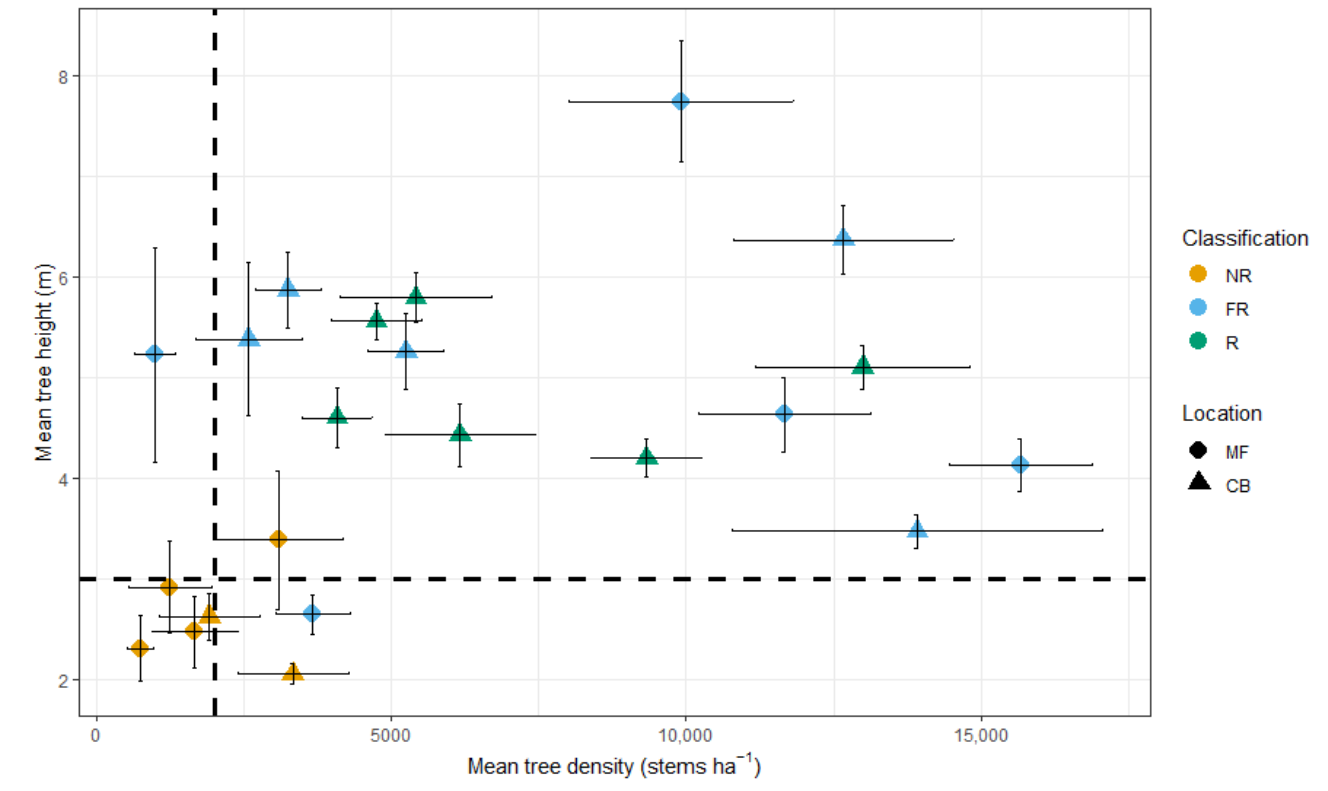
Figure 5. Mean tree height (m) and mean tree density (stems ha − 1 ) of each seismic line transect ( n = 22). Error bars represent one standard error of the mean. Colours indicate transect classification based on satellite imagery interpretation; Not Recovered (NR), Fractionally Recovered (FR), or Recovered (R). Symbols indicate the transect location: mature forest (MF) or cutblock (CB). The horizontal dashed line indicates the recovery criterion of 3 m tree height, and the vertical dashed line indicates the recovery criterion of 2000 stems ha − 1 .